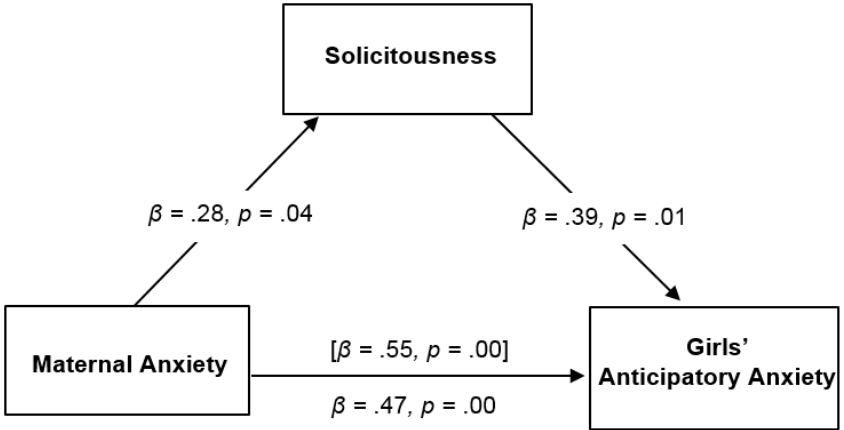
Figure 2. Mediating role of solicitousness in the relation of maternal anxiety with lab anticipatory anxiety for girls with chronic pain. Estimates of total effect of maternal anxiety on girls’ pain outcomes are presented in brackets, with values representing estimates of the total indirect effect of maternal anxiety on girls’ pain outcomes through maternal solicitousness presented below.